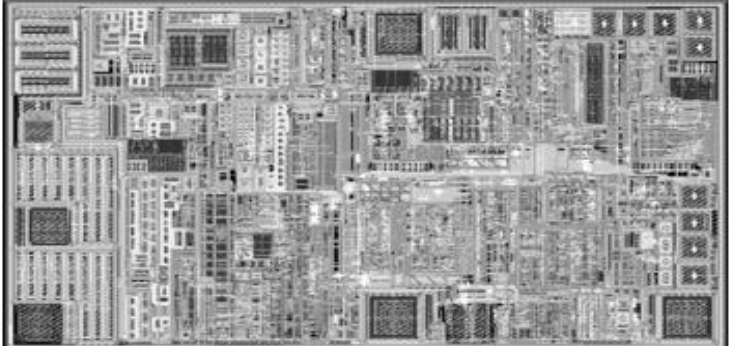
Figure 14. Integrated circuit (IC) layout of the control chip (Taiwan Semiconductor Manufacturing Company; 0.6 μm 7 V/12 V) featuring the novel frequency swapping technique.